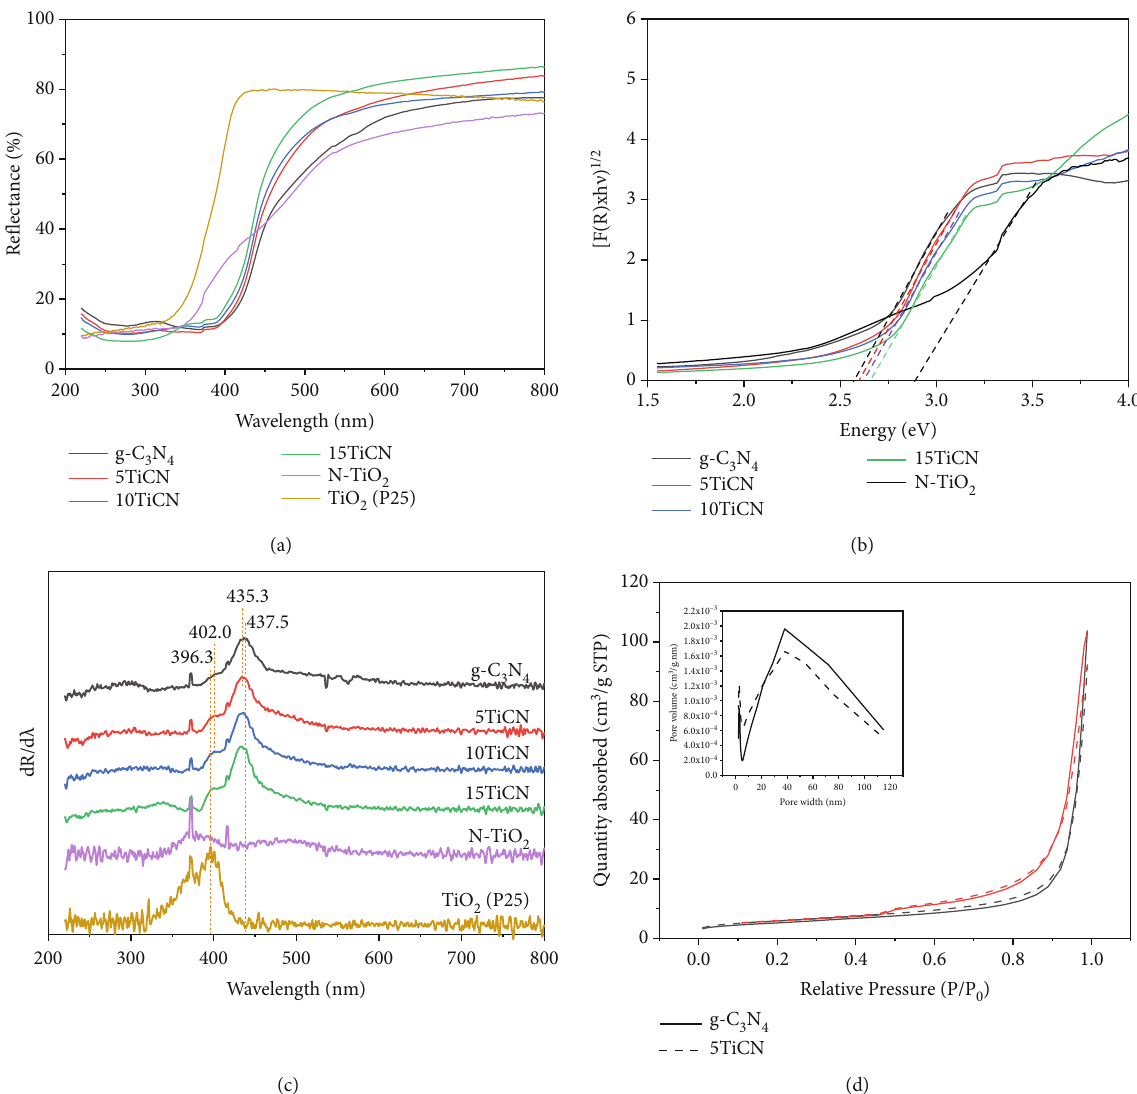
Figure 3: UV-vis DR spectra (a), energy bandgap determination by Kubelka – Munk function (b), and its corresponding di ff erential curves (c) of g-C N , N-TiO , and x TiCN composites; N 3 4 2 (solid line) and 5TiCN composite (dash line)